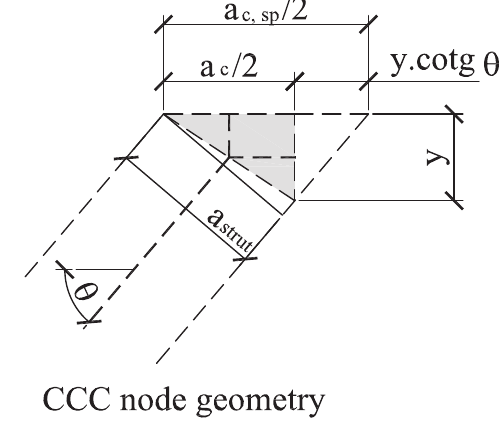
Figure 10 Equivalence between spreading of the load and node geometry proposed by Schlaich et al.